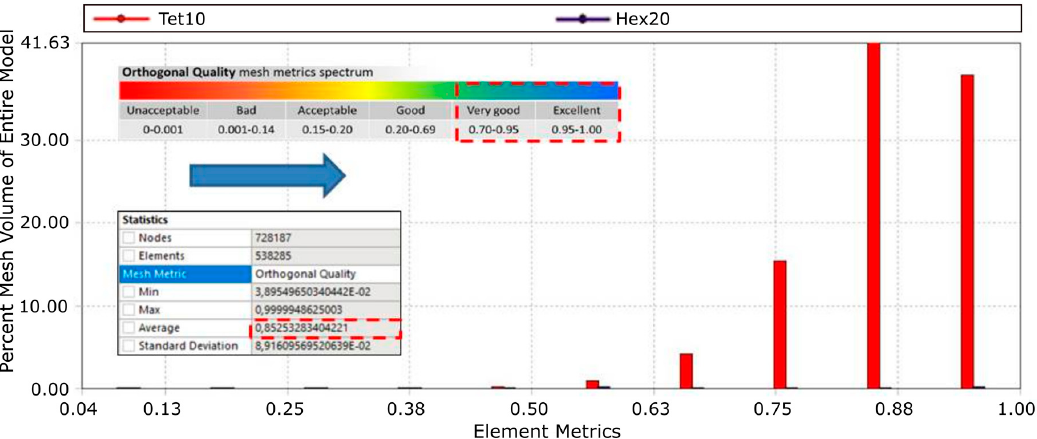
Figure 7. Structure of finite element grid in the model analyzed: orthogonal quality criterion.